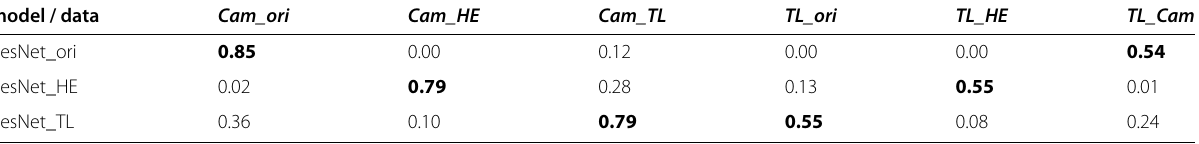
Table 1 Kappa-values for the ResNet models that were trained on different versions of the Camelyon16 data set model /